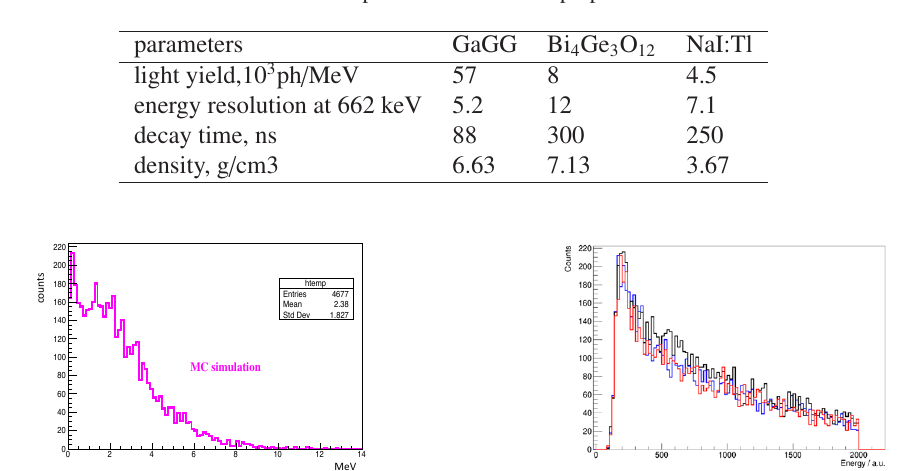
Table 1. Comparison of scintillator properties